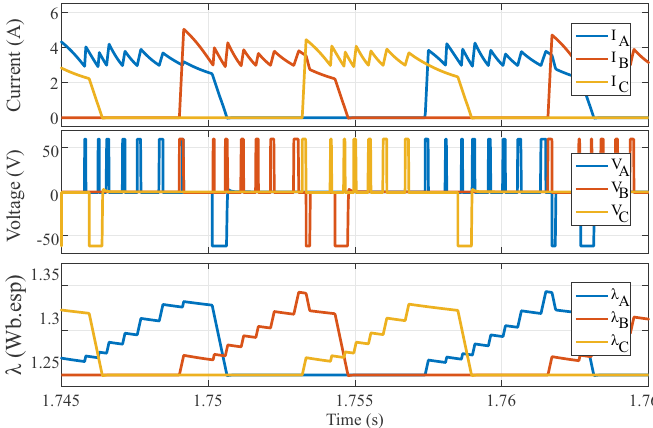
Figure 2. Simulated ideal currents, voltages, and flux linkages of a three-phase SRM.